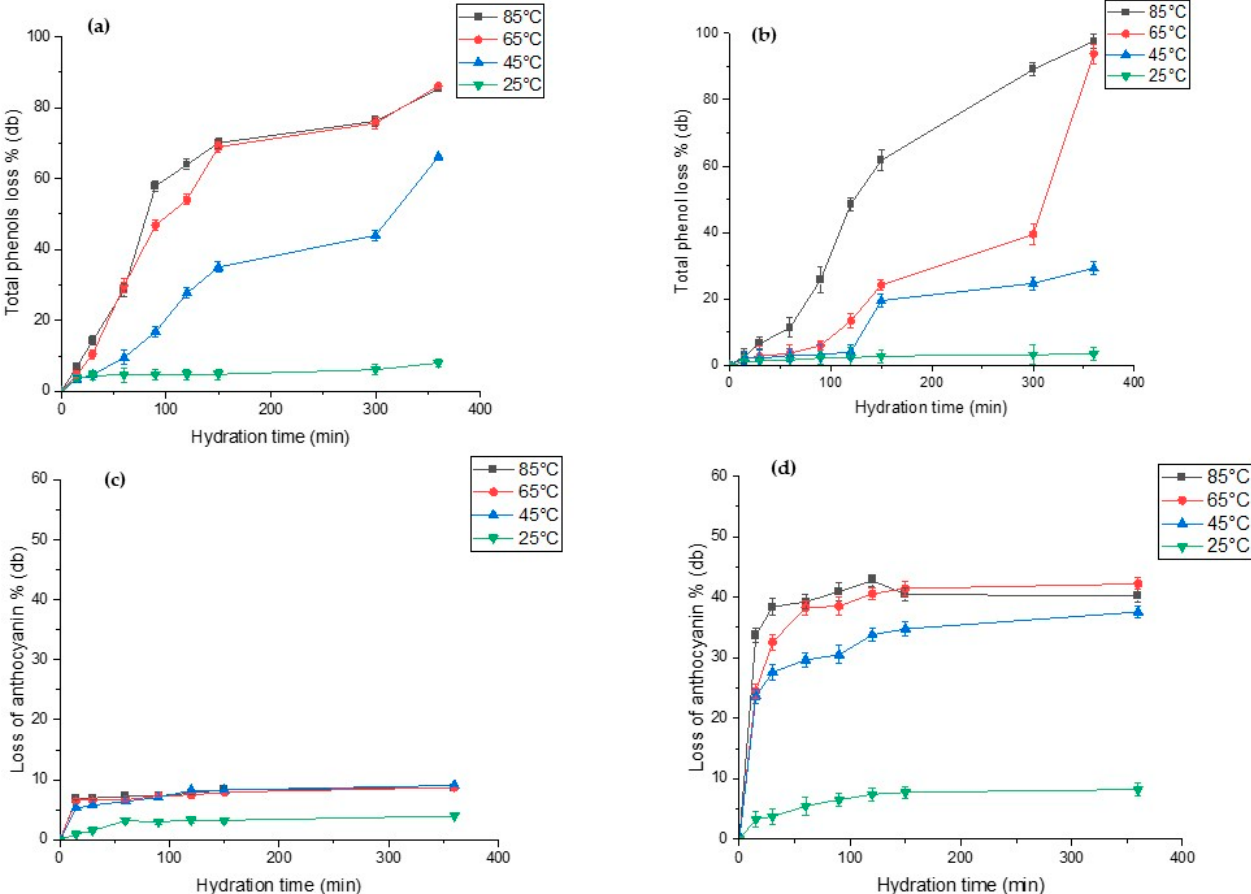
Figure 5. Total phenolic content (%) and total anthocyanin content (%) of hydration of water during hydration at four different temperatures for ( a , c ) L. albus and ( b , d ) L. angustifolius.